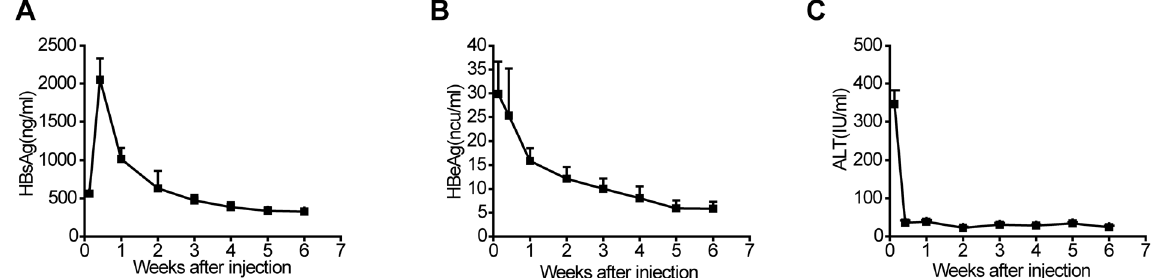
Figure 1. Hydrodynamic injection of pAAV/HBV1.2 plasmid leads to the persistence of HBV. ( A , B , C ) C57BL/6 mice received 6 μ g of pAAV/HBV1.2 plasmid through hydrodynamic injection. Serum HBsAg ( A ), HBeAg ( B ) and ALT ( C ) levels were detected at different time points after injection. Data are shown as mean ± SEM, n =